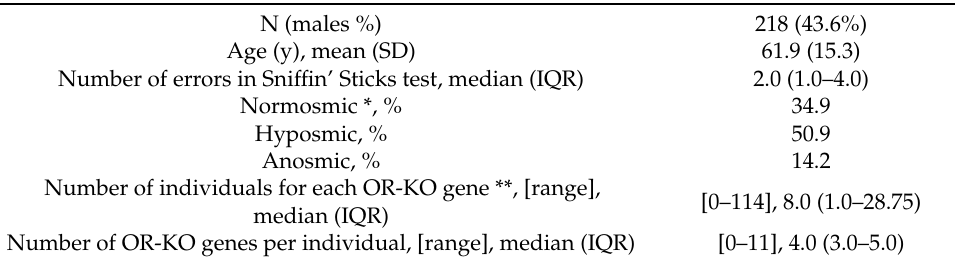
Table 2. Characteristic of individuals included in regression tree analysis. The table provides details of individual characteristics of subjects included in the regression tree analysis, indicating sex, age, number of errors in Sniffin’ Sticks test, and the classification of individuals in normosomic, hyposomic, anosmic, the numbers of individuals for each OR-KO gene and the number of OR-KO genes.